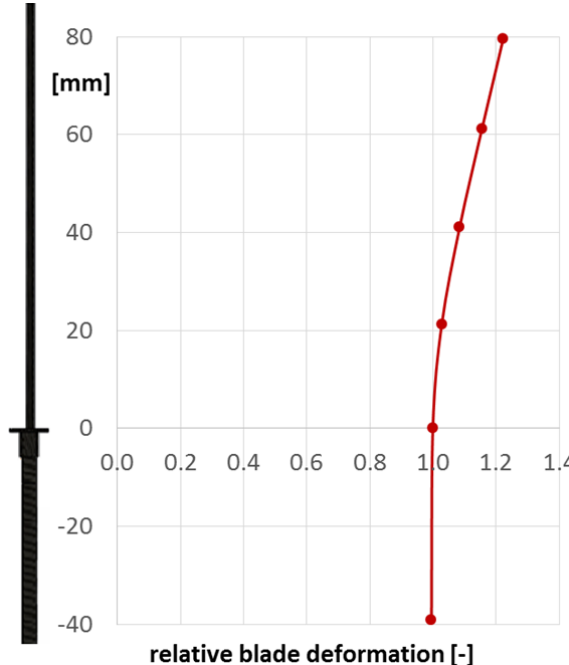
Figure 5. Experimentally measured blade flexible deformation in quiescent air at bending vibration.